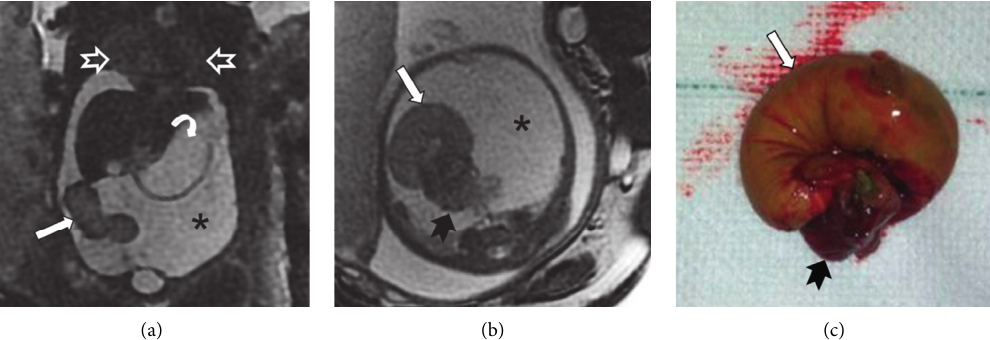
Figure 6: Intestinal volvulus. Gestational age 28 weeks and 2 days. (a) Coronal SSFSE T2. (b) Axial SSFSE T2. (c) Photograph of surgical specimen. Bichorial biamniotic gestation. One of the twins presents with an intestinal volvulus, along with meconial ileus and meconial peritonitis. The presence of massive ascites (black asterisk) that compress both lungs (empty white arrowhead) is shown. The stomach is dilated (curved white arrowhead). Dilated and volvulated ileal loops (solid white arrow) with distal necrosed clustered loops (solid black arrowhead) are shown. Fetal MRI diagnosed intestinal volvulus not described in fetal ultrasound providing useful information for perinatal management and prognosis over fetal ultrasound.